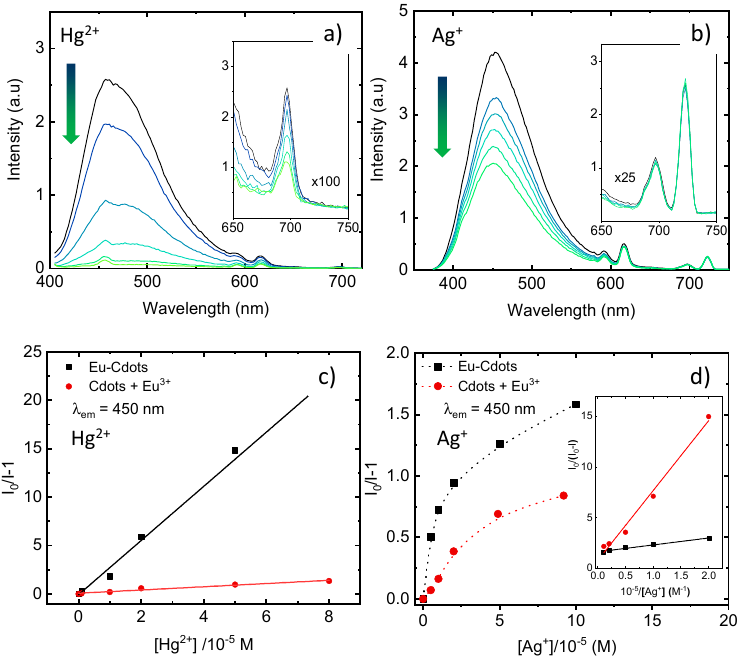
Figure 5. Emission quenching of Eu-Cdots by Hg 2+ and Ag + . Emission spectra of the Eu-Cdots aqueous dispersion in the presence of Hg 2+ at λ exc = 390 nm ( a ) and Ag + at λ exc = 360 nm ( b ), and corresponding Stern–Volmer plots of the quenching measured at λ em = 450 nm upon addition of Hg 2+ ( c ) and Ag + ( d ). In ( c , d ), similar quenching data are shown for the quenching of Cdots + Eu 3+ mixture. The inset on panel ( d ) shows linear relationship between I 0 /( I 0 − I ) with the reciprocal of the Ag + following Equation (2). The plot of the intensity ratio ( I 0 / I − 1) of the Eu-Cdots emission ( λ em = 450 nm) as a function of the concentration of Hg 2+ is linear up to the concentration of 80 µ M (Figure 5c), obeying a Stern–Volmer type